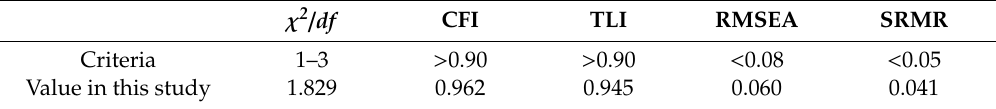
Table 6. Fitting index and